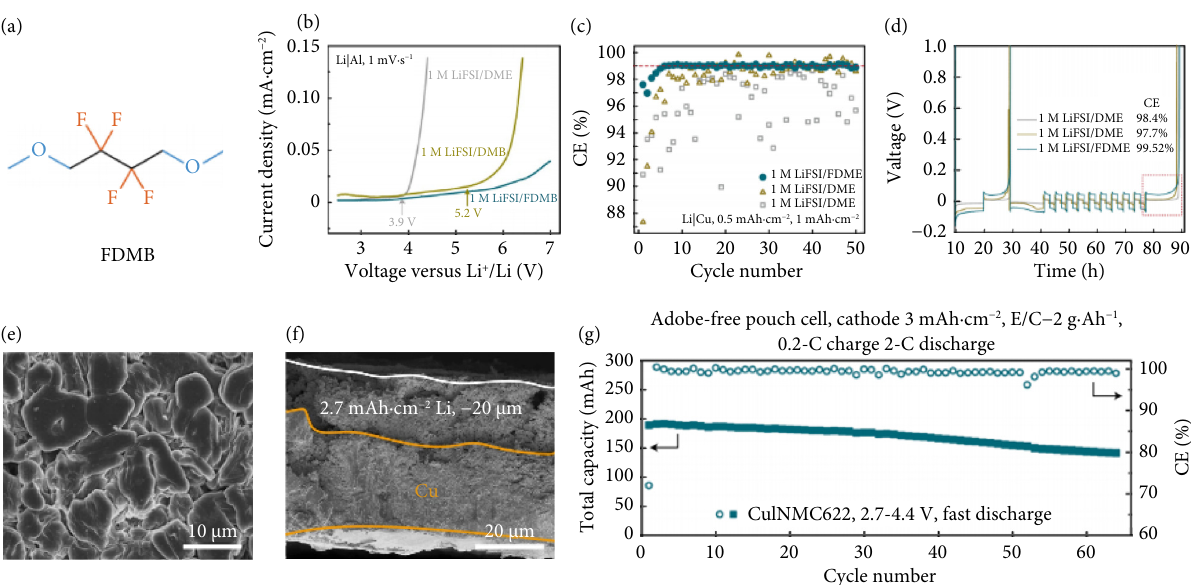
Fig. 5 (a) The molecular structures of FDMB. (b) The oxidation stability of three electrolytes in Li||Al half cells. (c,d) The cycling and CE of Li||Cu half cells using different electrolytes. (e,f) Li morphology in 1 M LiFSI/DMB after 70 cycles. (g) The full battery performance of anode-free Cu||NMC622 pouch cell with 1 M LiFSI/ DMB electrolyte. Reprinted with permission from ref. [56], © The Author(s), under exclusive licence to Springer Nature Limited